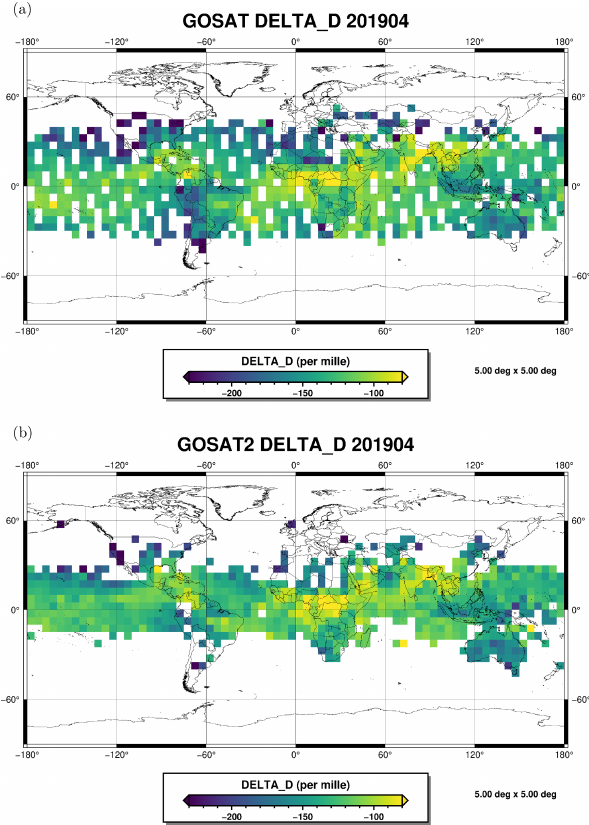
Figure 7. Maps of gridded δ D data for April 2019: (a) GOSAT; (b) GOSAT-2.